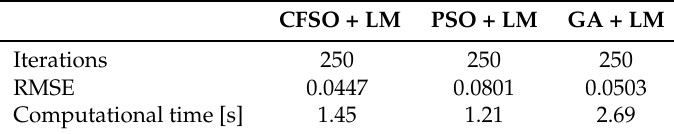
Table 4. Comparison against classic global optimisation algorithms.